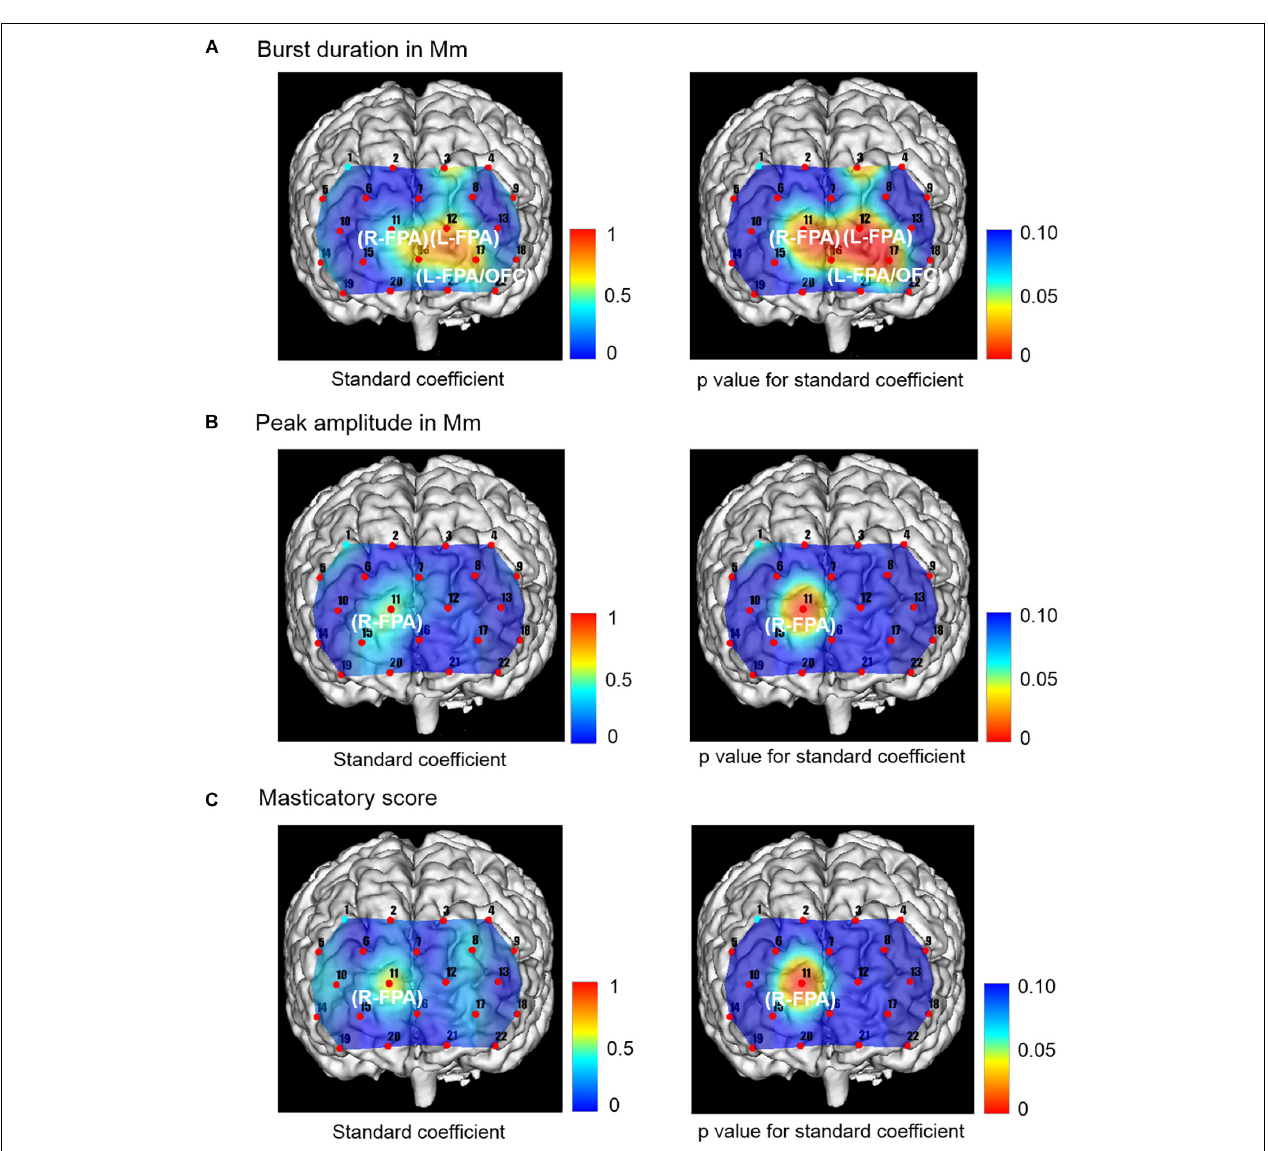
FIGURE 5 | Topographical maps showing standard coefficient and p values between independent variables of Mm muscle activities and occlusal force and prefrontal oxygenated hemoglobin concentration [(oxy-Hb)] of the dependent variable in the right and left sides, respectively. (A) The change rate in burst duration in the Wearing condition was significantly and positively associated with the change rate in prefrontal [oxy-Hb] during the chewing task in R-FPA (CH 11), L-FPA (CH 12), and L-FPA/OFC (CH 17). (B) The change rate in peak amplitude in the Wearing condition was also significantly and positively associated with the change rate